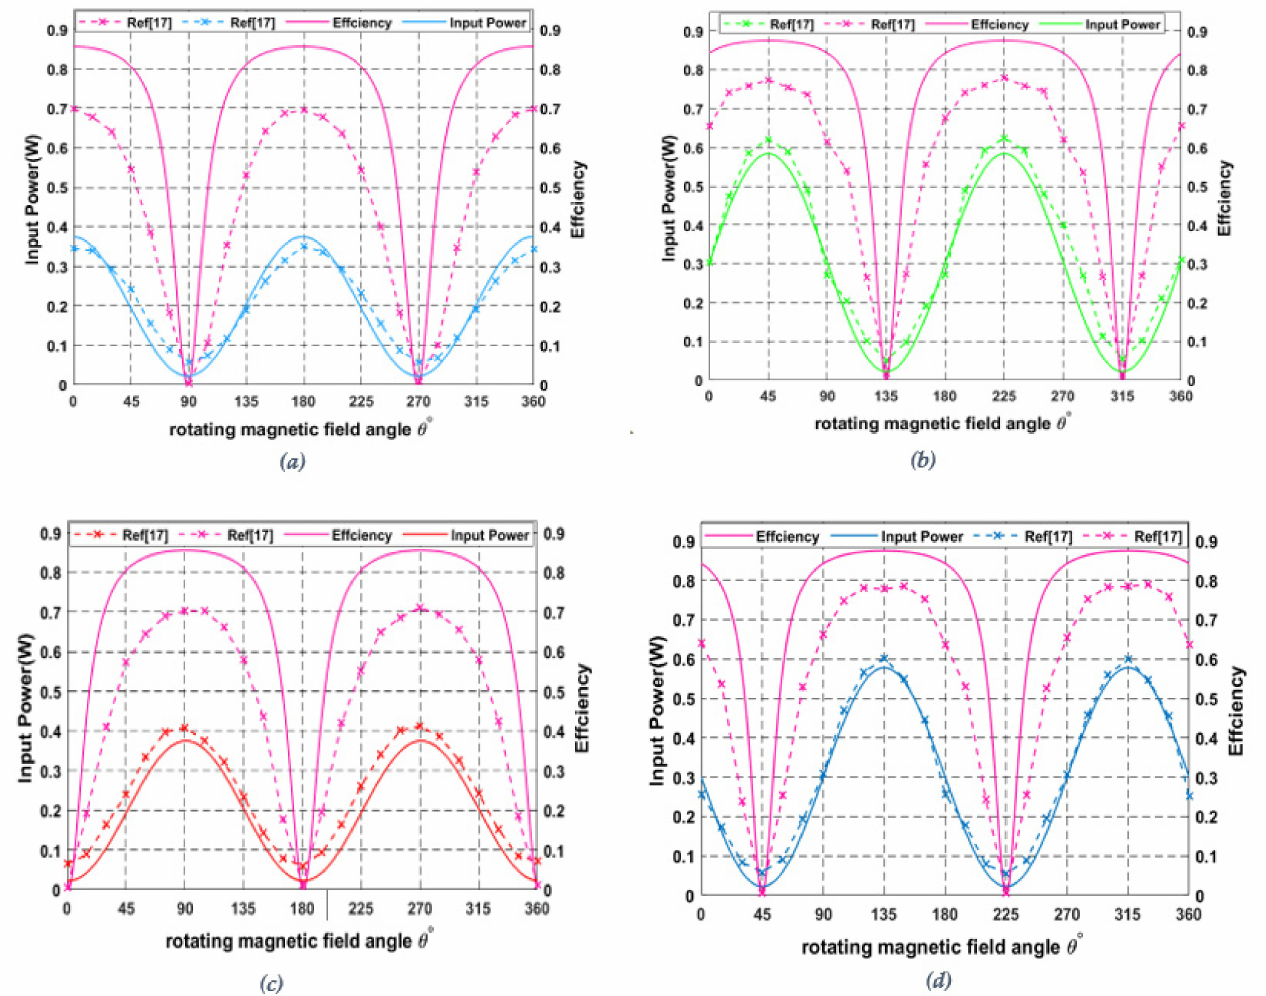
Figure 9. ( a – d ) Input power and efficiency plots when the receiver is placed at 0 ◦ , 45 ◦ , 90 ◦ , and 135 ◦ , respectively, in the presence of a rotating magnetic field when d = 0.3